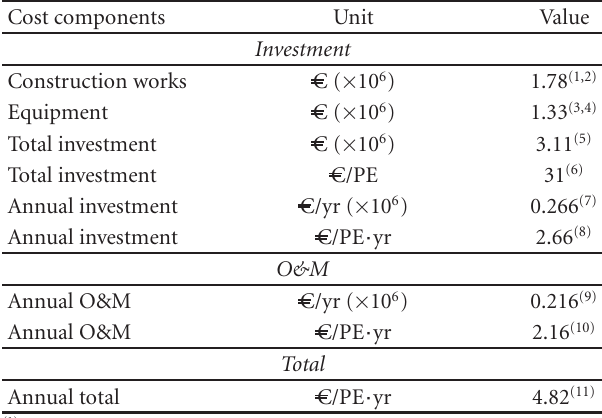
Table 2: Summary of total cost estimated for the proposed bio- methanization plant for 100,000PE (adapted from Ozturk et al.